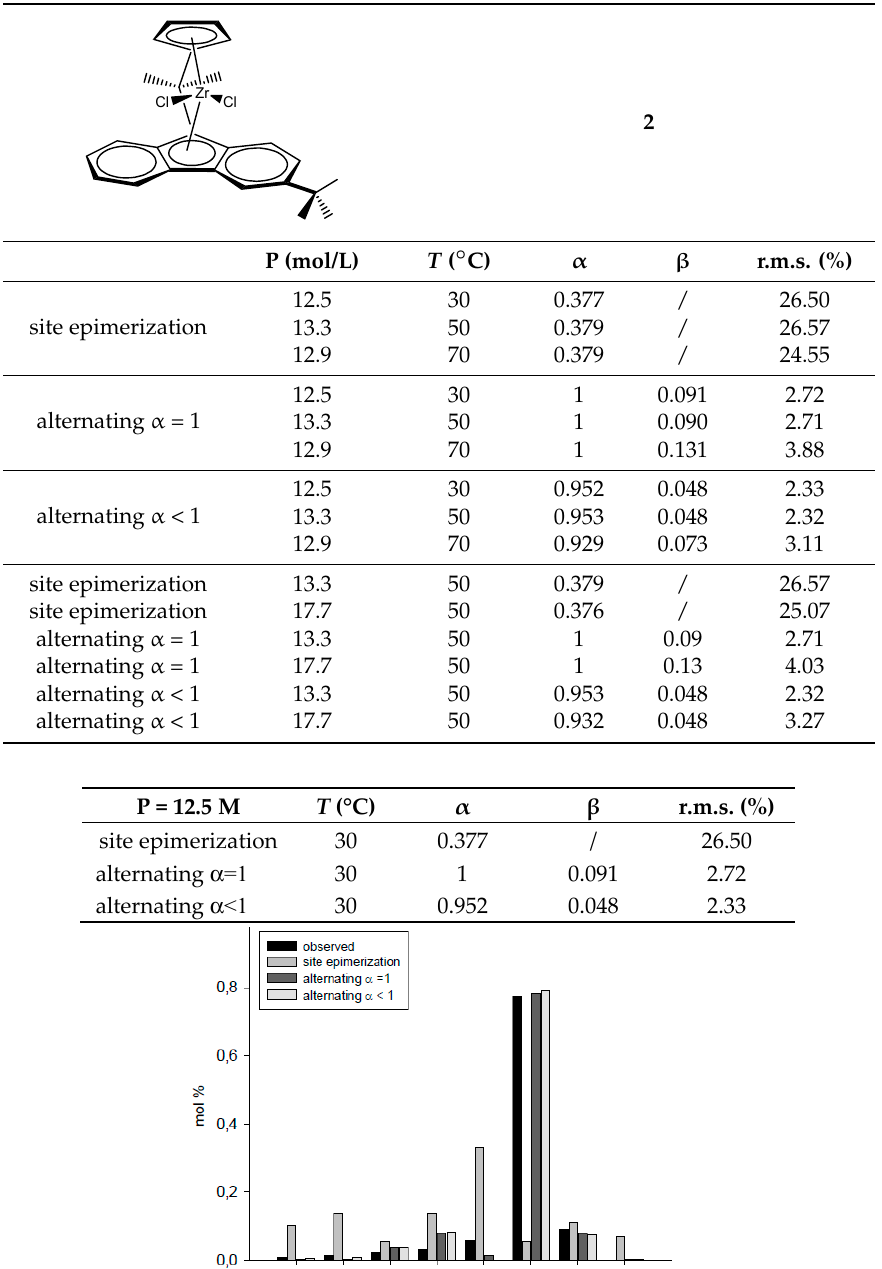
Table 4. The r.m.s. errors for given statistical models for propene polymerizations made with 2 /MAO.